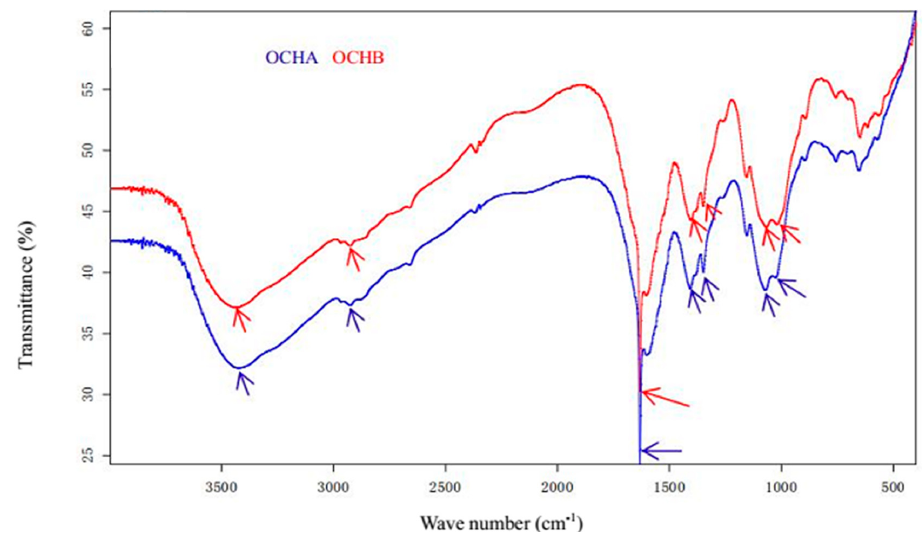
Figure 4. The Fourier transform infrared spectra of OCHA and OCHB. The blue line is the infrared spectrum of OCHA. The red line is infrared spectrum of OCHB.